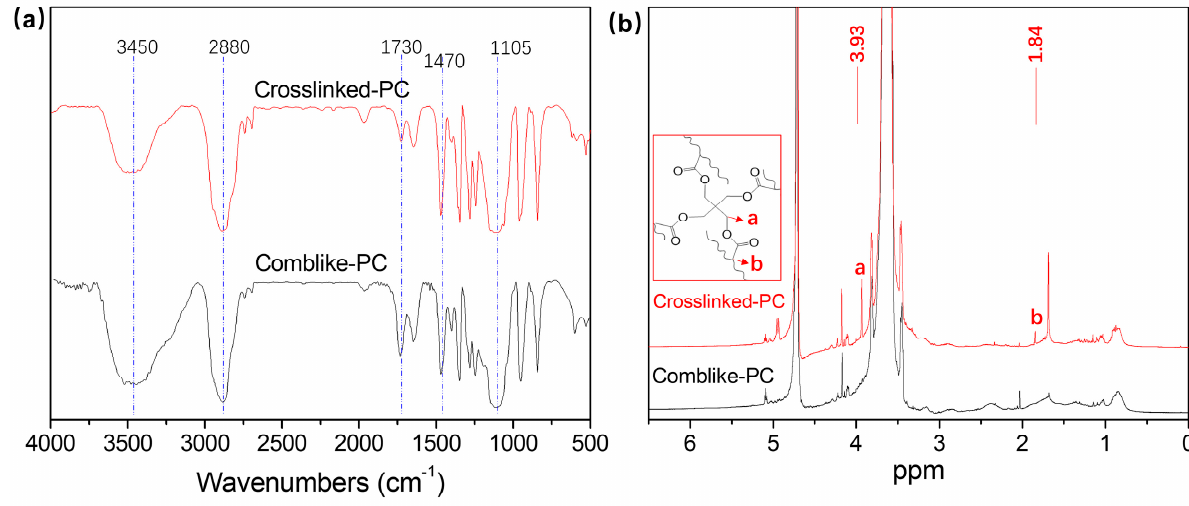
Figure 2. FTIR ( a ) and 1 H − NMR ( b ) spectra comb-like-PC and crosslinked-PC.